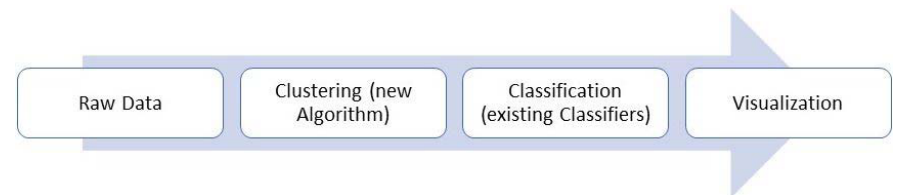
Figure 4. A typical ML